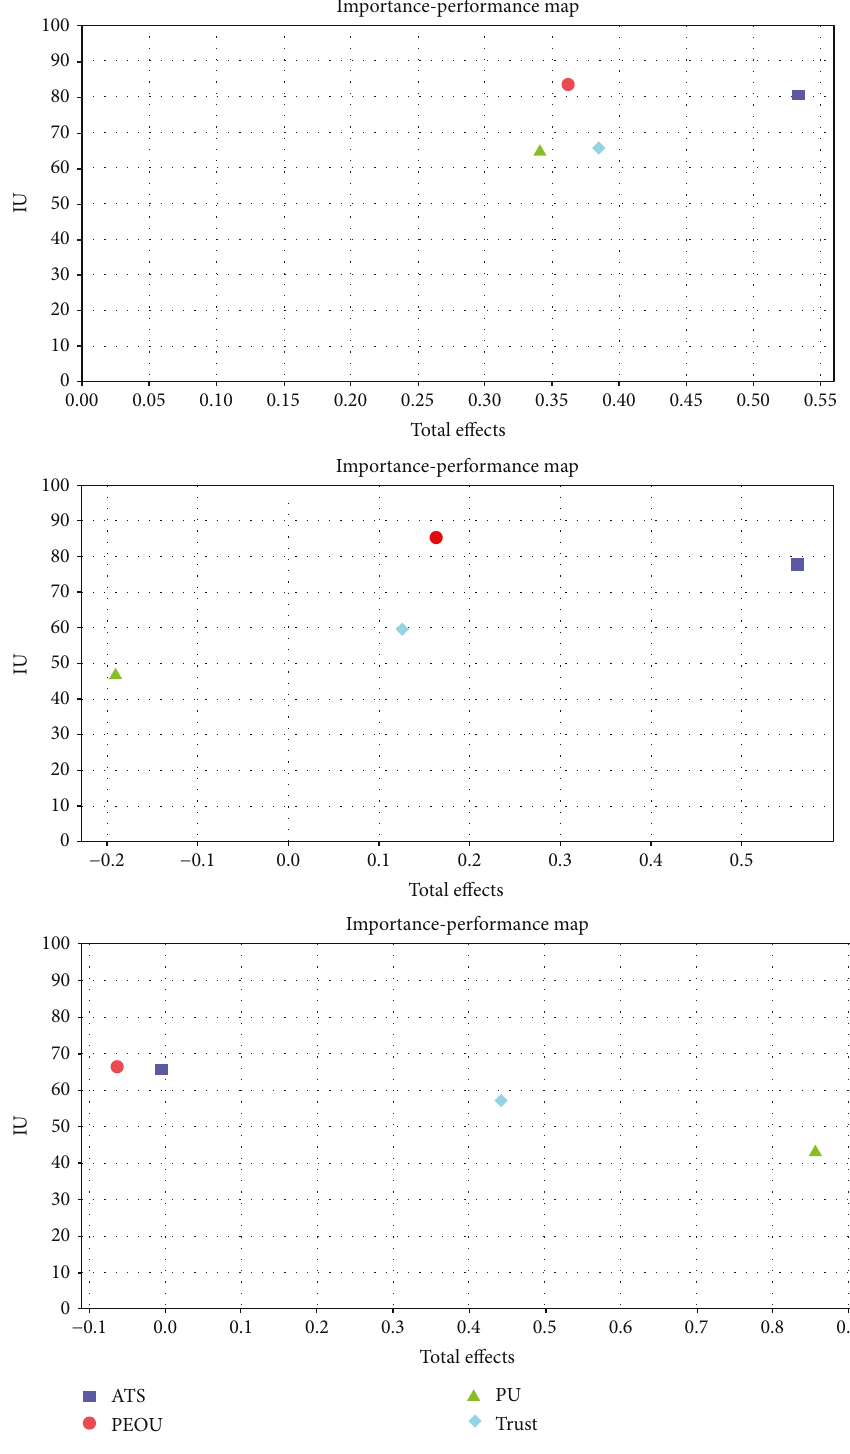
Figure 4: Importance-performance maps for k = 1 , k = 2 , and k = 3